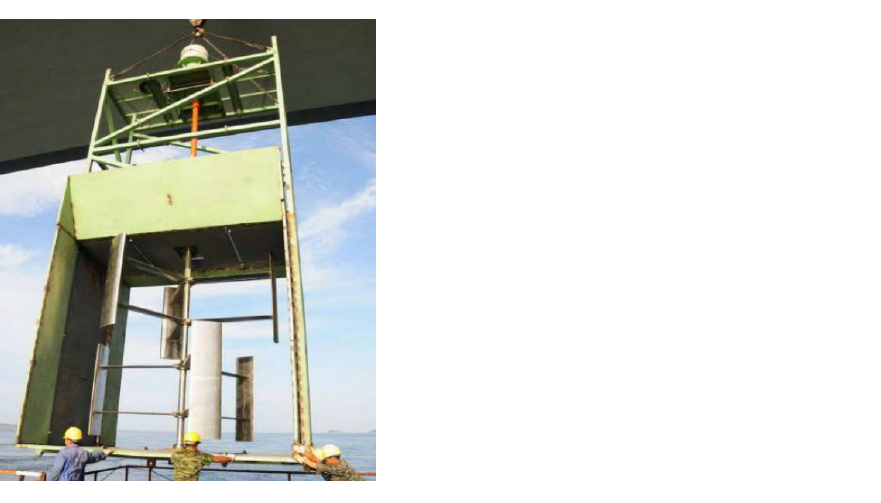
Figure 27. A 15 kW vertical-axis direct-drive TCPGS. Reproduced from [73].